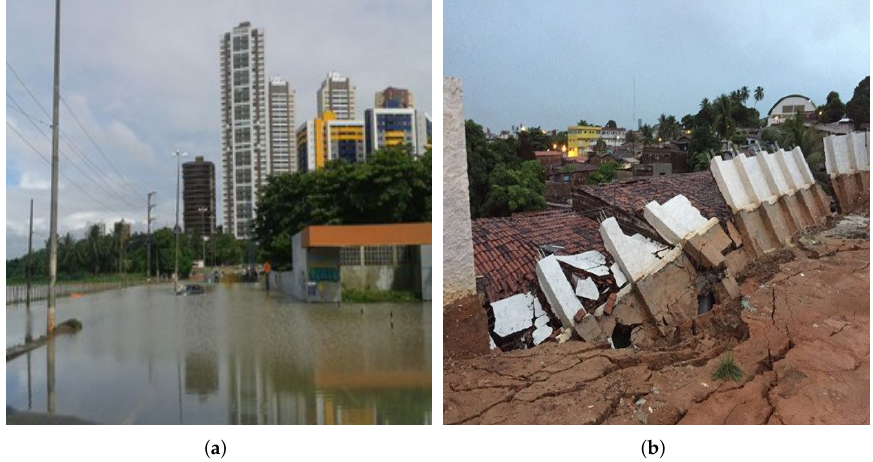
Figure 15. One of the municipalities affected by the extreme rain. ( a ) flooding in Municipality of João Pessoa in Paraíba state; ( b ) collapse of houses in municipality of João Pessoa in Paraíba state. Photograph: Natalia Xavier/G1 and Walter Paparazzo/G1).